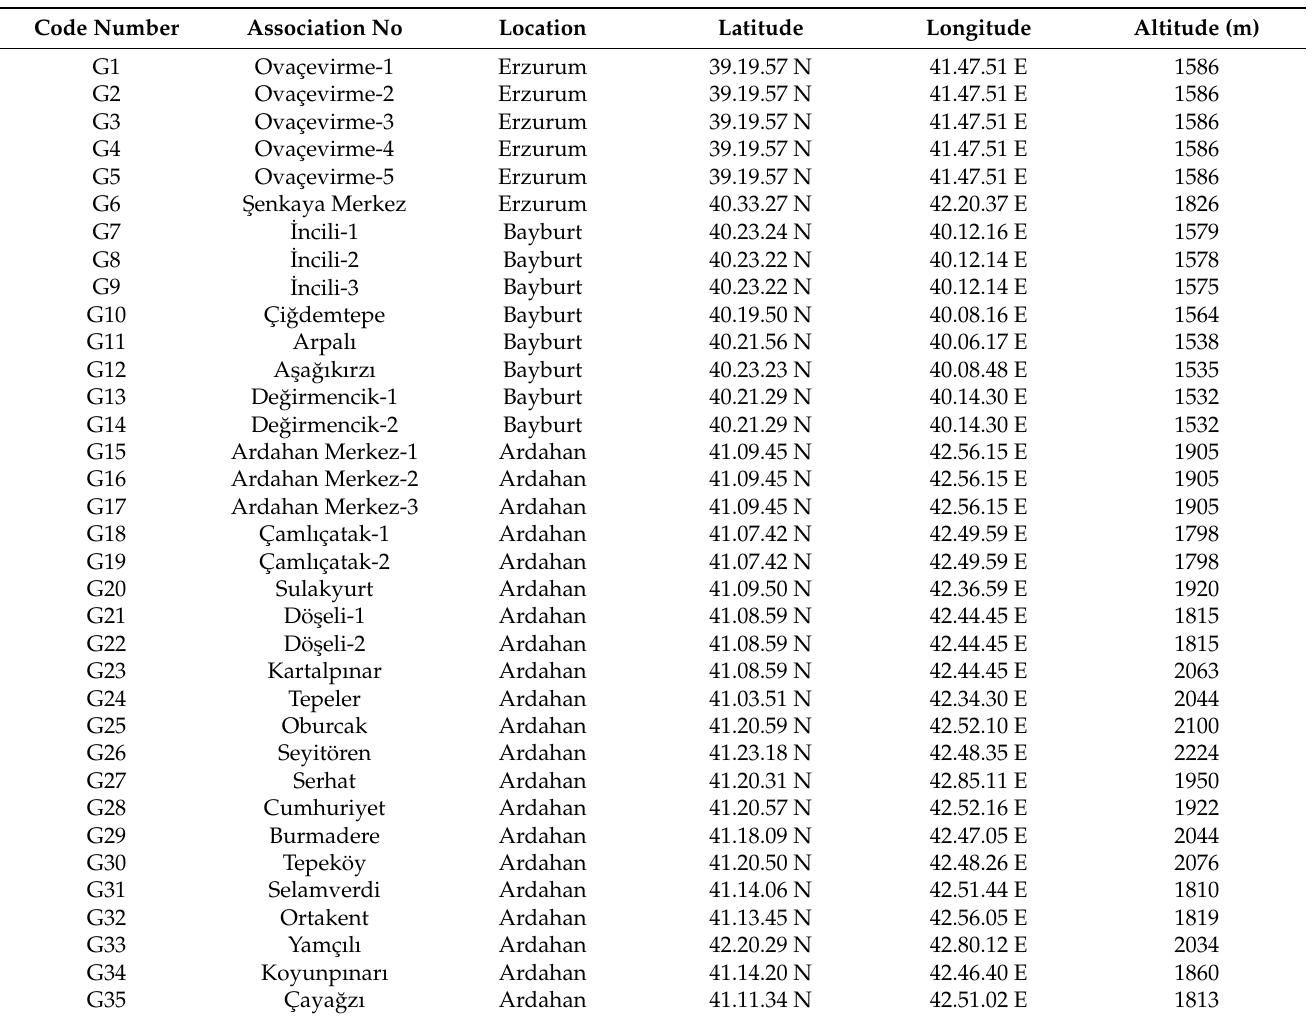
Table 1. List of forage pea ( P. sativum ssp. arvense L.) by collection and